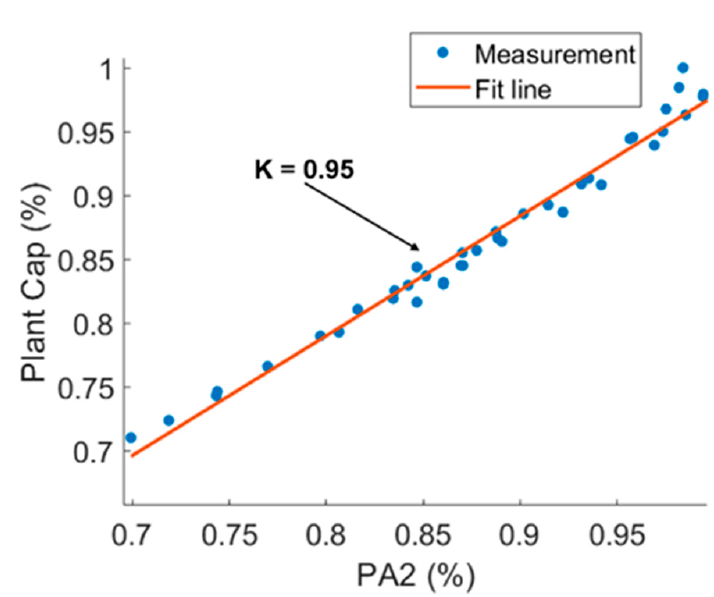
Figure 9. The relation between change of PA 2 (cid:13) and the change of PA 5 (cid:13) - 2 (cid:13) (Plant Cap). In Equation (7), Q 5_2 is the IC peak area corresponding to the negative leading plat- form, Q 1 is the area corresponding to PA 1 (cid:13) , and Q high is the area corresponding to the high polarization section. Q 5_2 can be further expressed